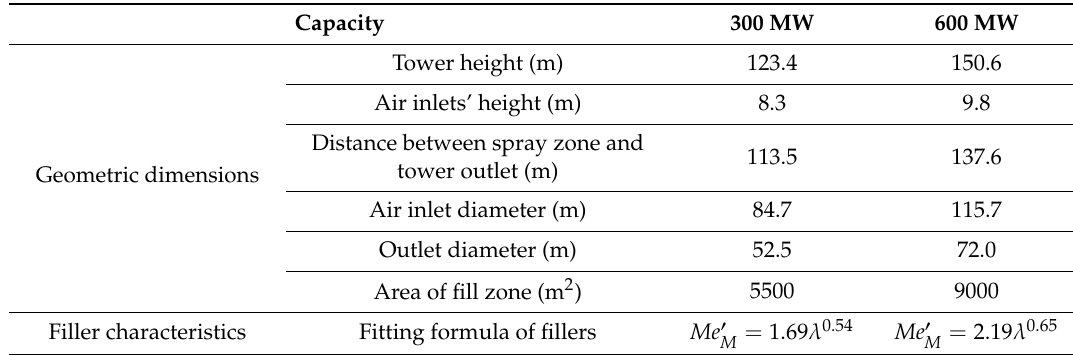
Table 2. Geometric dimensions of the